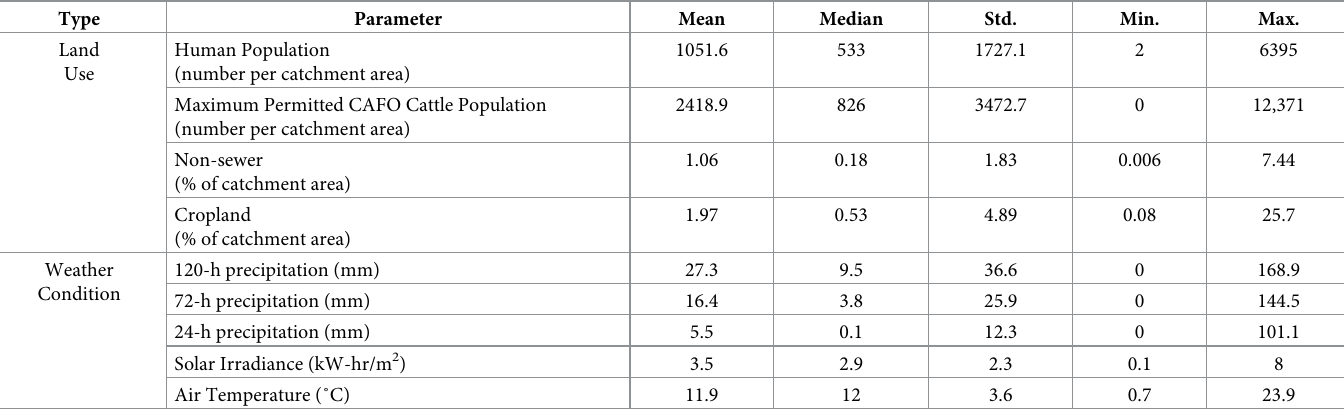
Table 1. Land use and weather condition summary statistics over study